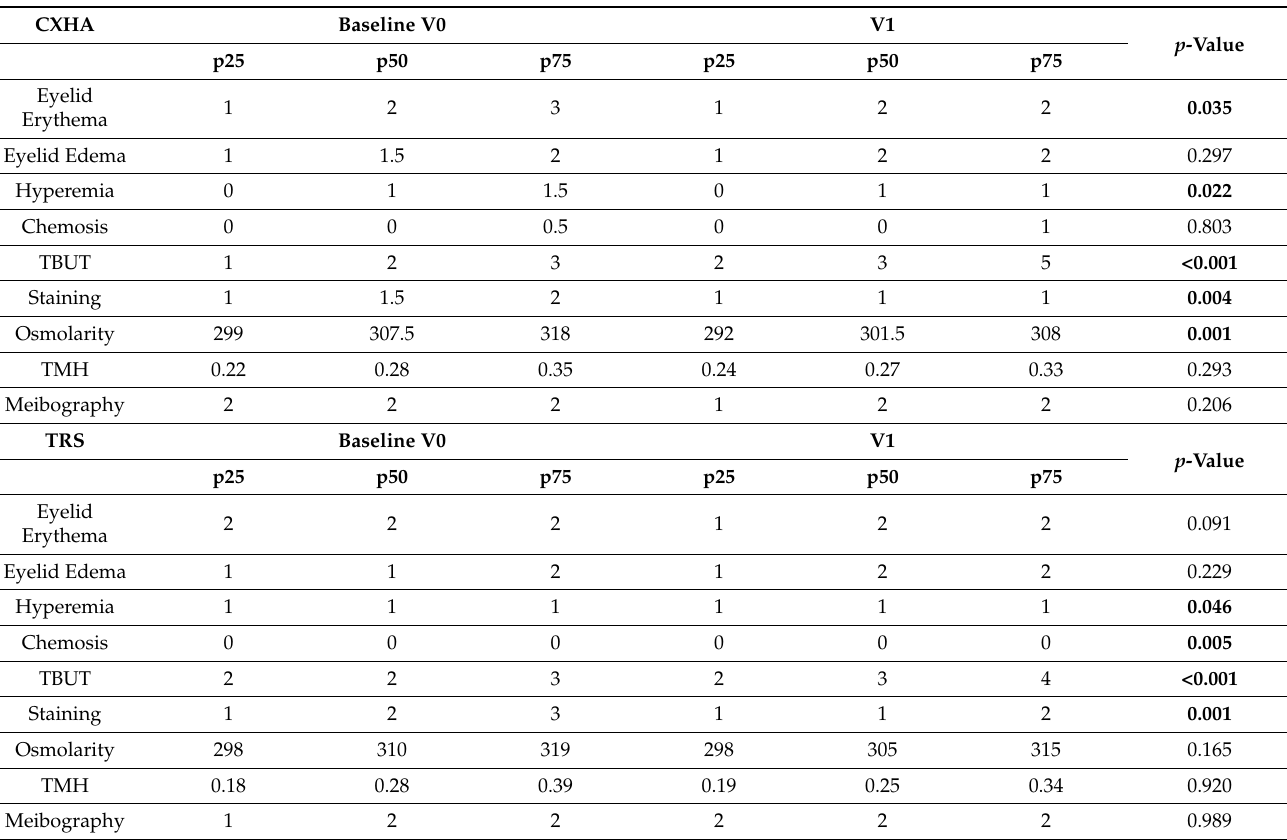
Table 2. Descriptive Statistics for both treatments and p -value for Wilcoxon sign rank test. Numerical variables are expressed as the median (p50), 25% (p25) and 75% (p75) percentiles. Statistically significant p values are highlighted in